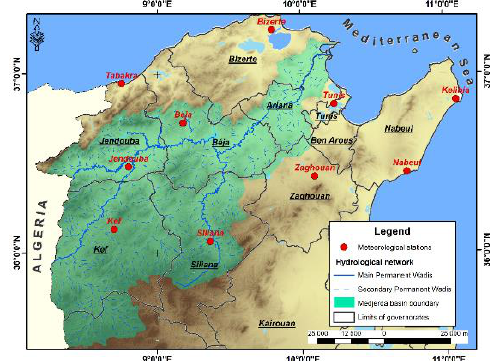
Figure 1. Location of meteorological stations in the north of Tunisia with governorates administrative limits and Medjerda basin boundary.